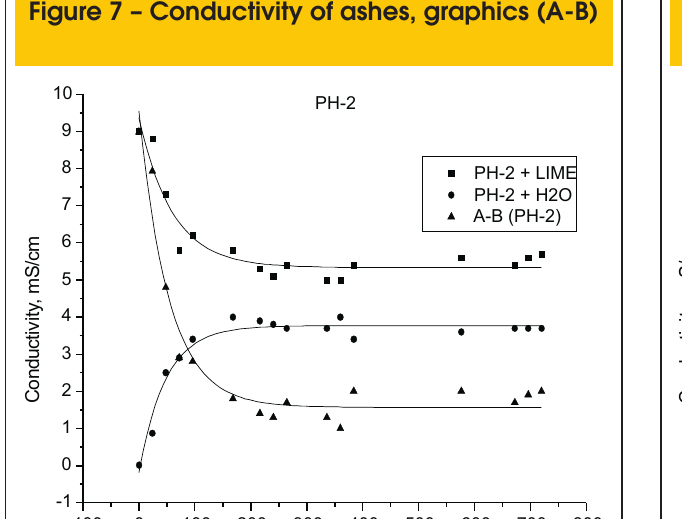
Figure 9 – Conductivity of ashes, graphics